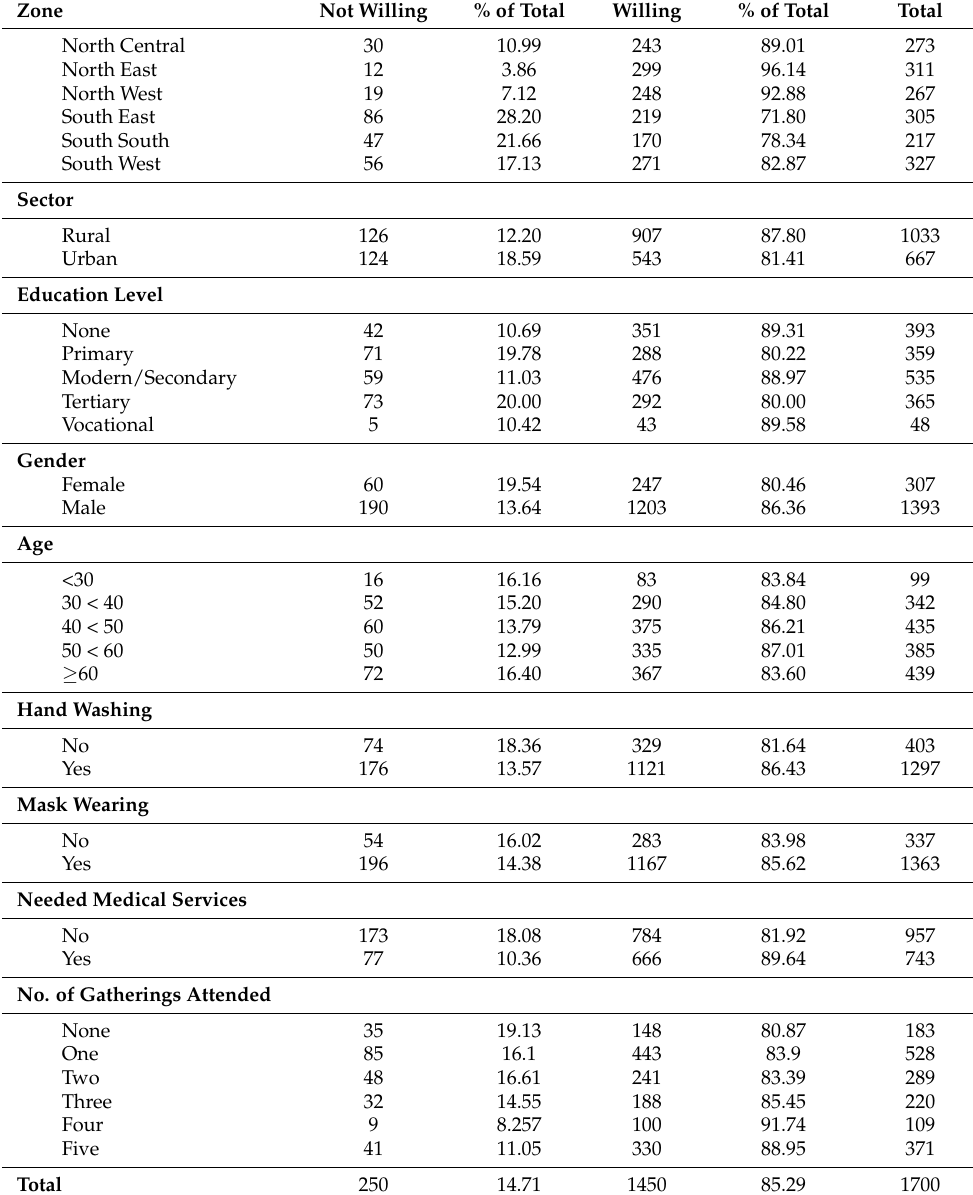
Table 2. Distribution of Respondents’ Willingness to be Vaccinated against